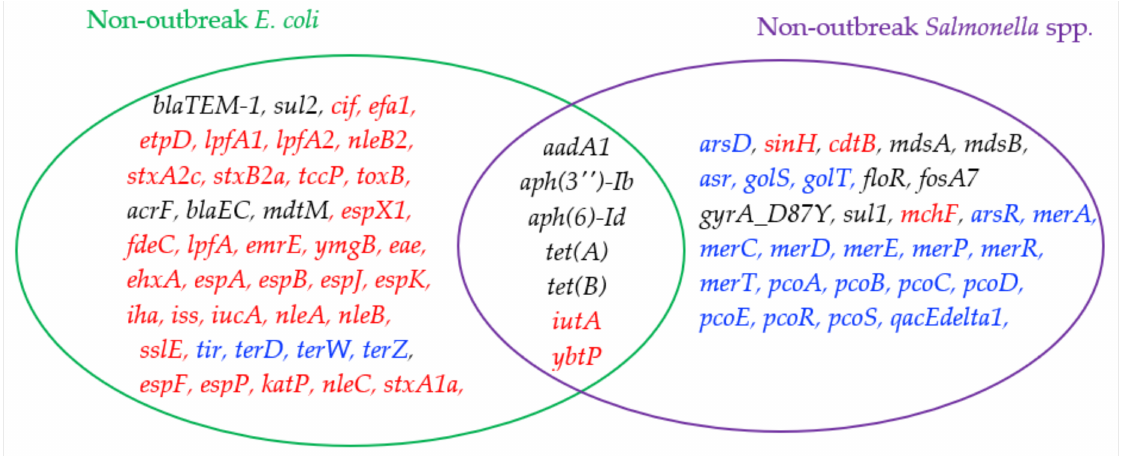
Figure 5. A comparison of outlier genes detected in non-outbreak E. coli and non-outbreak Salmonella